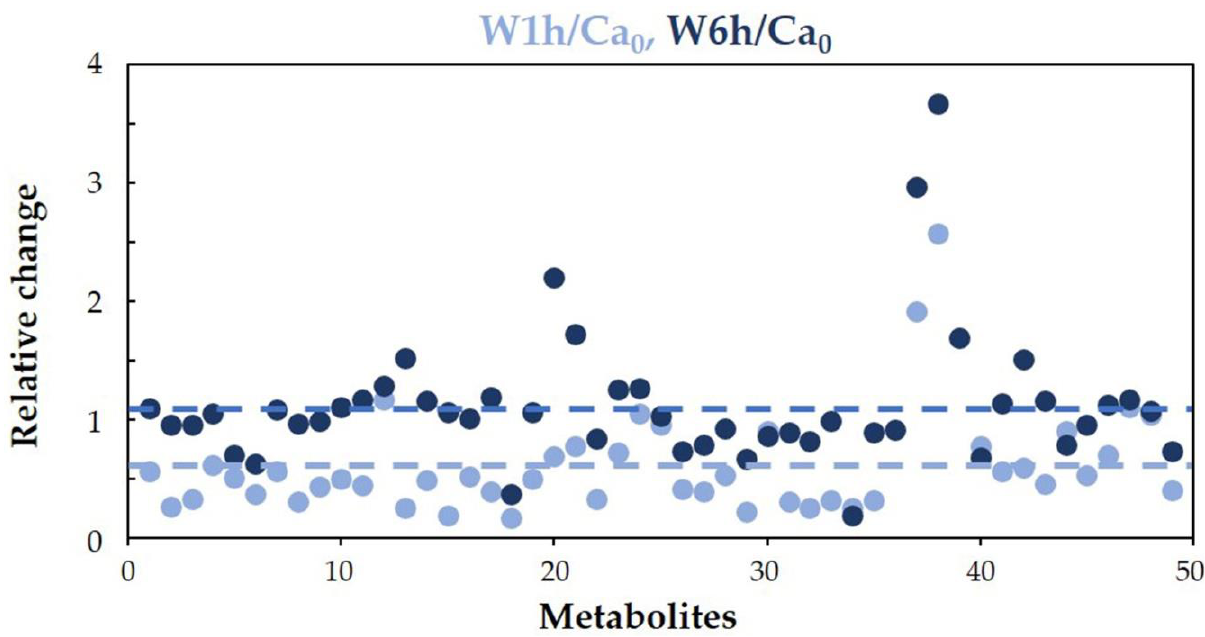
Figure 3. Distribution of the relative changes in intracellular metabolite concentrations, after incu- bation in water at 37 °C for 1 h (sky blue) or 6 h (dark blue), compared to the reference condition (Ca 0 ). Intracellular concentrations of metabolites were normalized per total cell number. Broken lines indicate the mean value of the ratios W1h/Ca 0 and W6h/Ca 0 calculated for all the identified metabolites (0.6 for 1 h and 1.1 for 6 h incubation). Each dot represents a quantified metabolite; dots aligned vertically correspond to the same metabolite (1 h and 6 h).